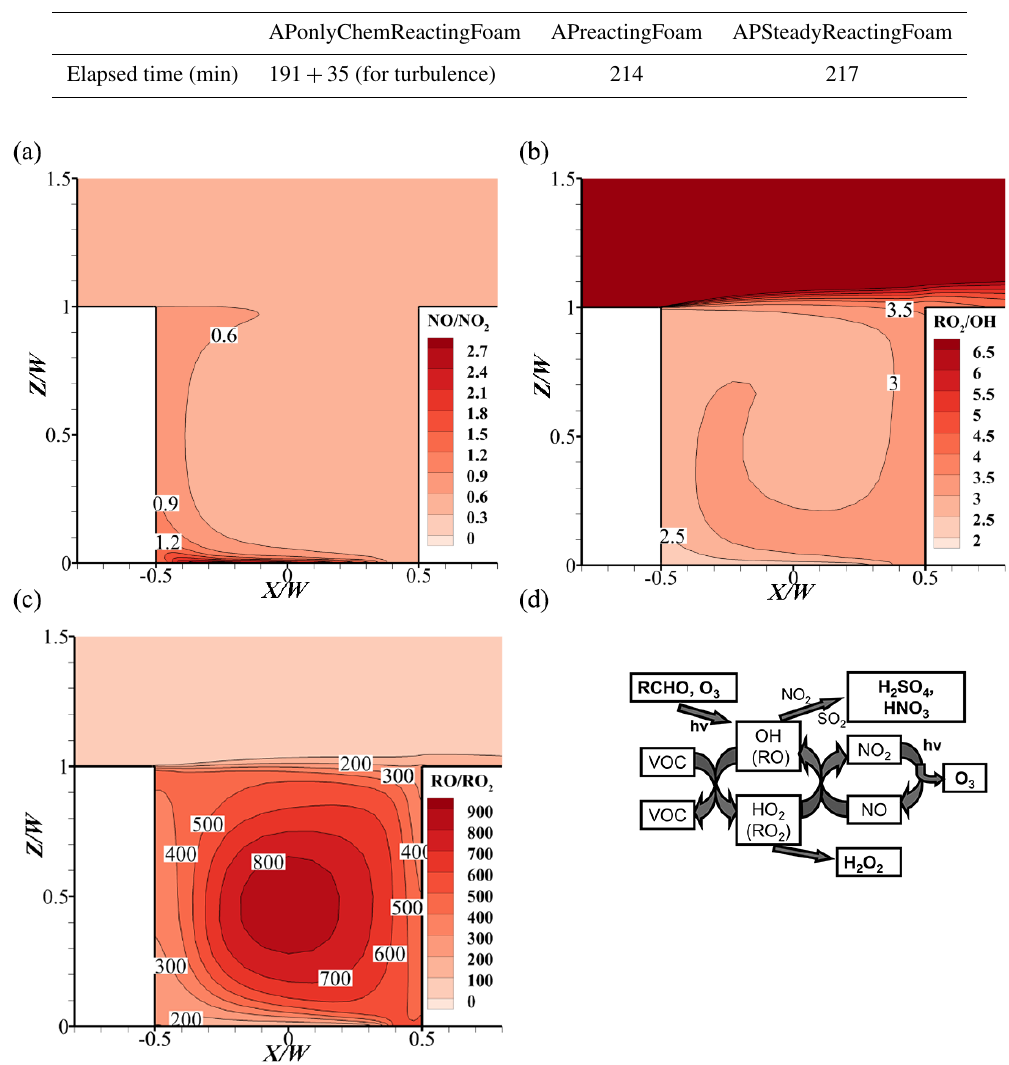
Table 6. The elapsed time of the three solvers.